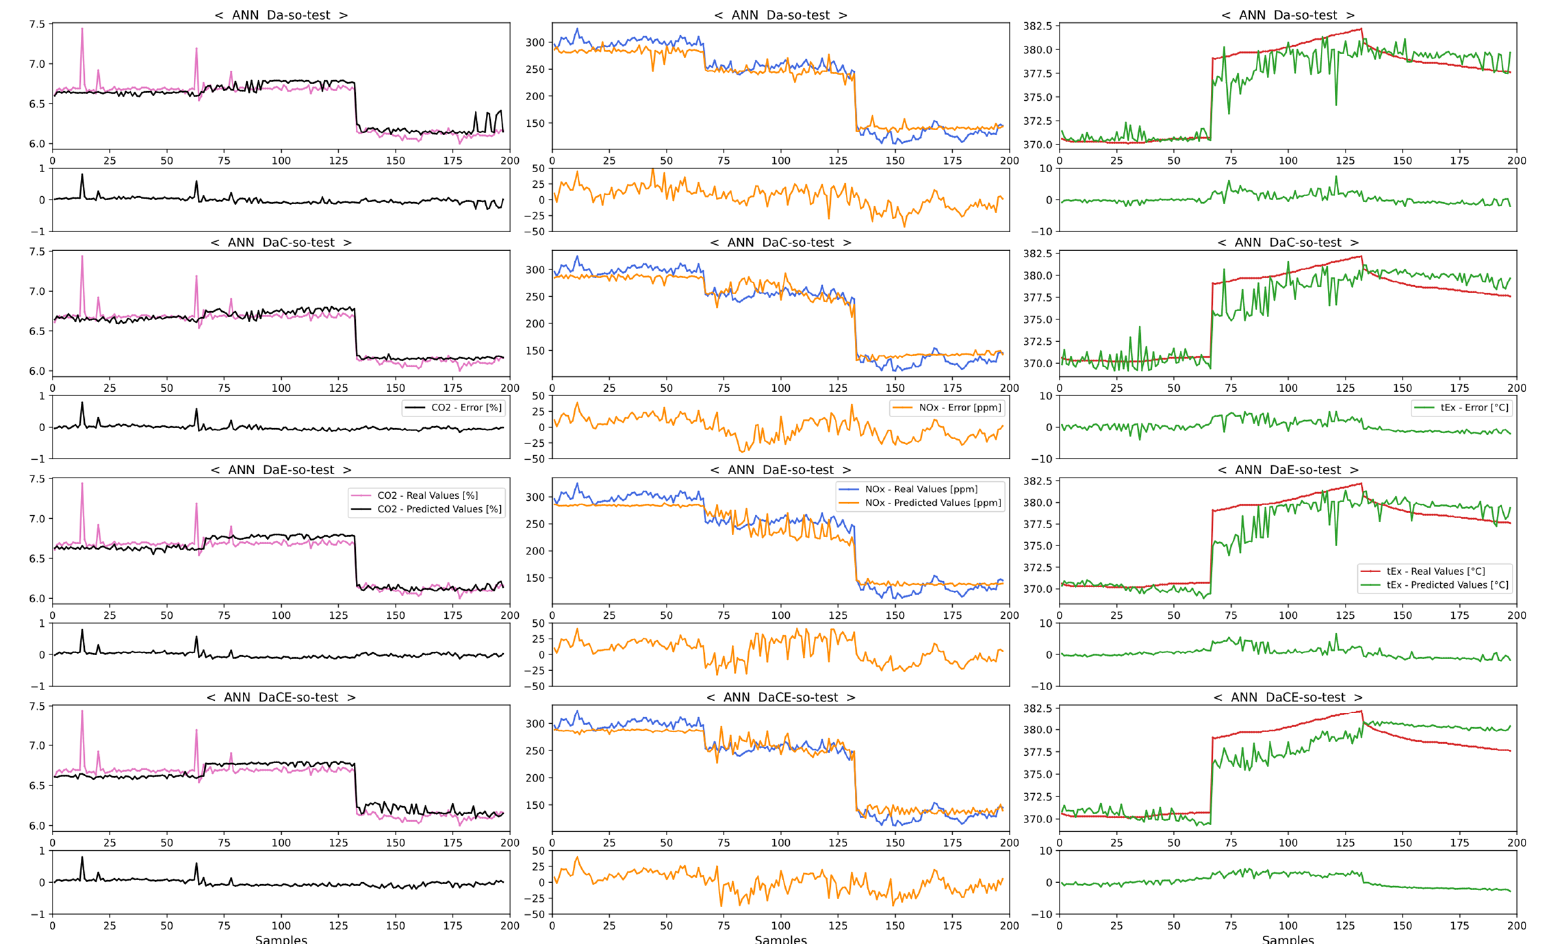
Figure 14. Comparison of real and predicted values for different datasets with ANN models in SCR mode.